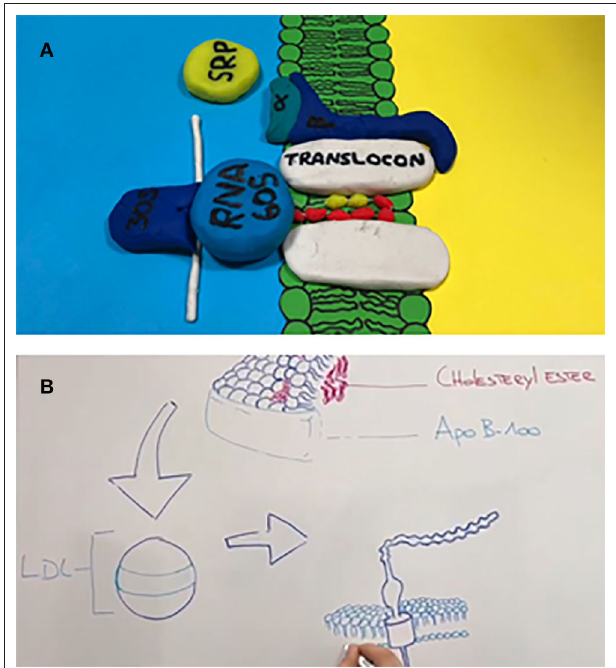
Topic 4: Protein targeting to the mitochondrial matrix “Girl trying to get into ‘The Matrix’ nightclub”